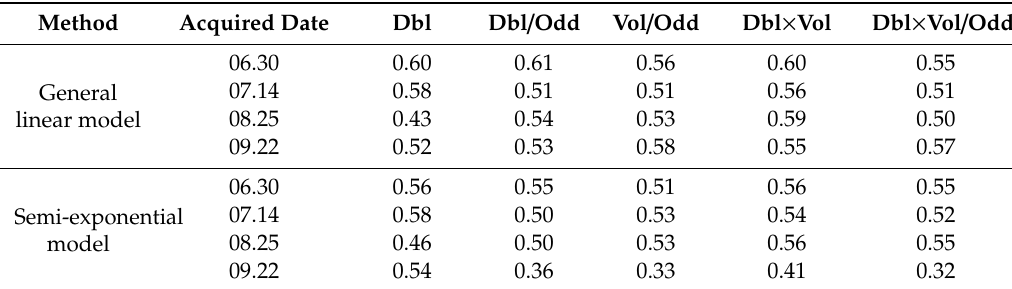
Table 4. The coe ffi cient of determination (R 2 ) between the measured and the estimated plots GSV obtained by GLM and semi-exponential model using five un-fused and fused polarimetric characteristics from single SAR images.